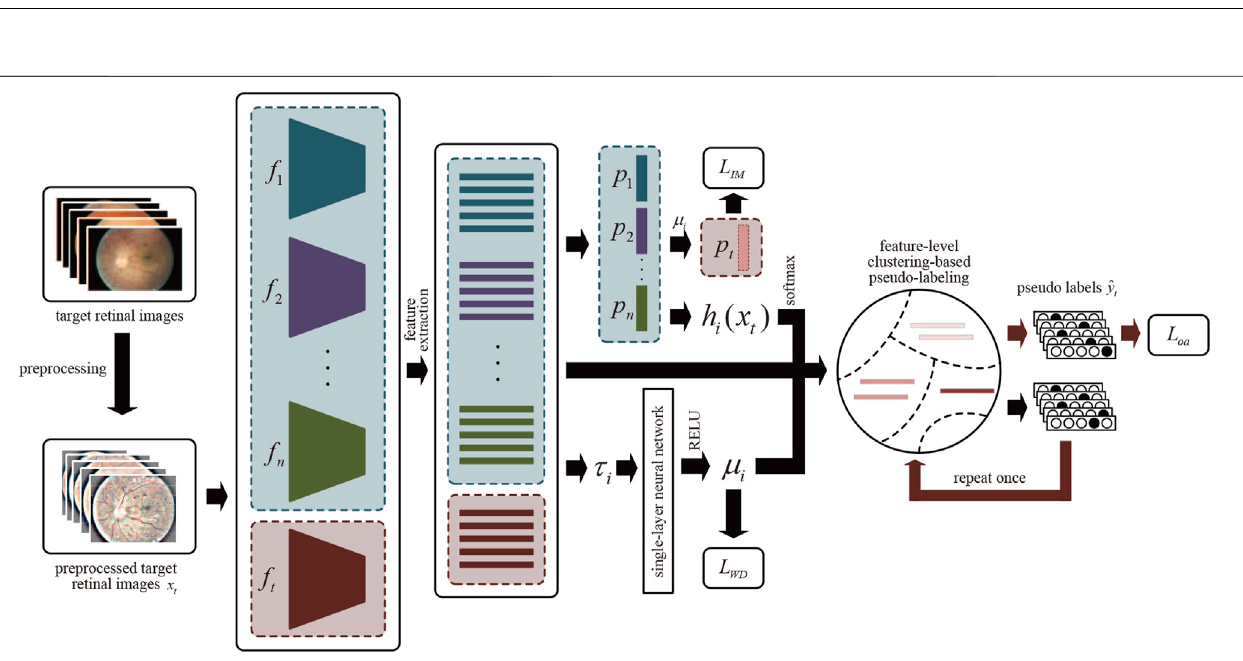
FIGURE3| TheoverviewofMMDAarchitecture.Afterpreprocessing,weobtainthefeaturesoftargetretinalimagesbysourcemodels f i | n i (cid:1) 1 andtargetmodel f t ,and calculate the weight of each model μ i using the single-layer neural network. The output of the target classi fi er is de fi ned by the source classi fi ers with fi xed parameters. Pseudo labels ^ y t for each retinal image x i are obtained after the process of feature-level clustering-based pseudo-labeling.